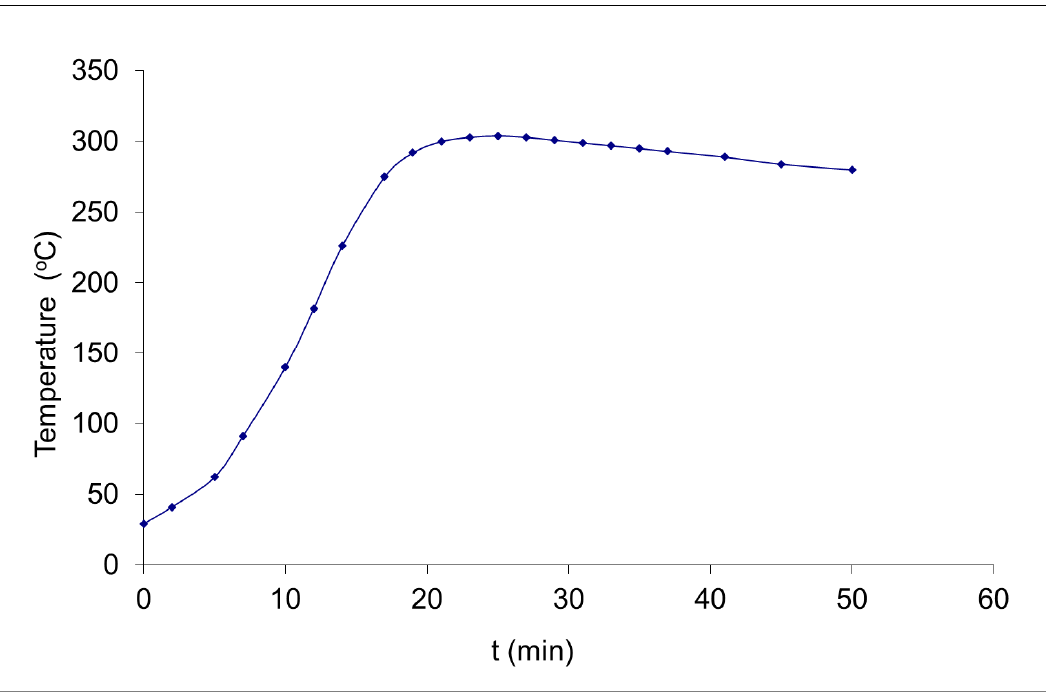
Figure 3. Experimental temperature profile for a typical barley straw torrefaction experiment.